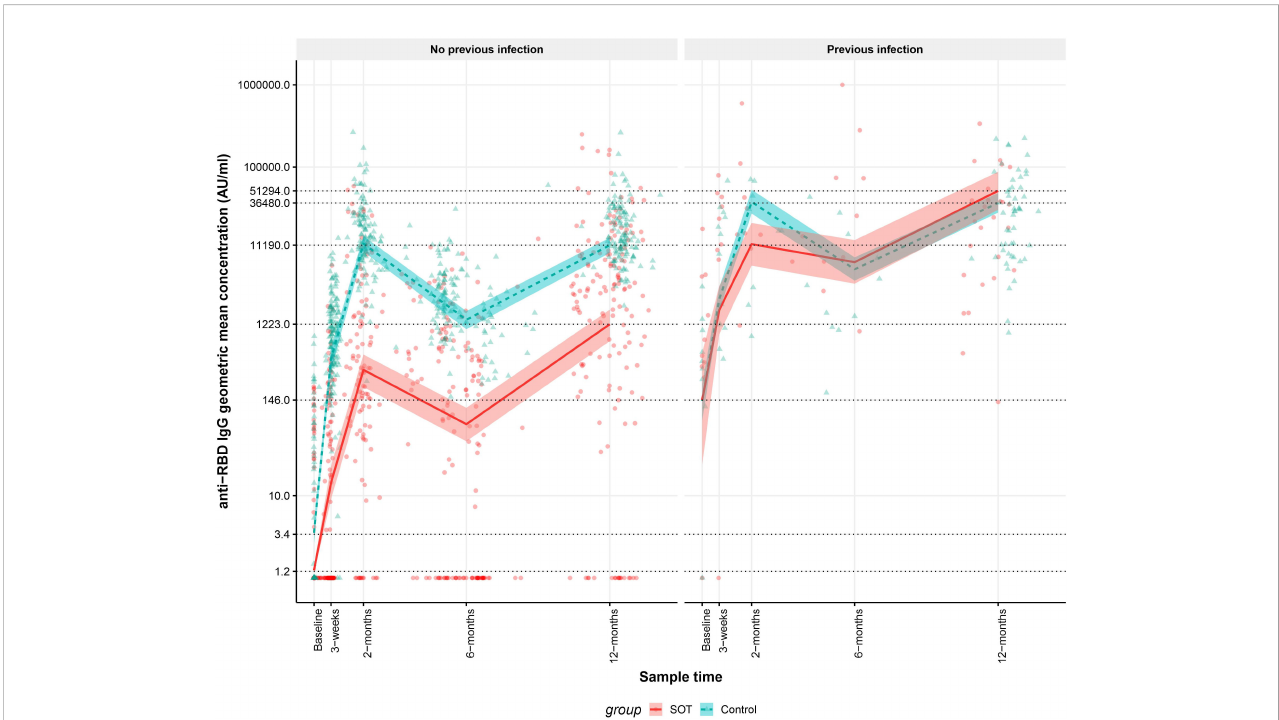
FIGURE 2 Kinetics of the modeled anti-receptor-binding domain (RBD) Immunoglobulin G (IgG) geometric mean concentrations (GMCs) in solid organ transplant (SOT) recipients and controls with and without previous infection within 12 months after the fi rst BNT162b2 dose and observed anti-RBD IgG concentrations. The data include 189 SOT recipients (red) and 189 age and sex matched controls (blue). A sample is de fi ned as previously infected when an individual has a positive SARS-CoV-2 PCR test prior to the sample or SARS-CoV-2 Nucleocapsid antibodies are present in the sample or a previous sample from the same individual. The modeled anti-RBD IgG GMCs in AU/mL with 95% con fi dence intervals are plotted on top of each indiviudal sample ’ s measured anti-RBD concentration in AU/mL. The y-axis is on a log10 scale. The dashed horizontal lines indicate modeled anti-RBD IgG GMC values for SOT recipients and controls with and without prior infection at baseline and 12 months after fi rst BNT162b2